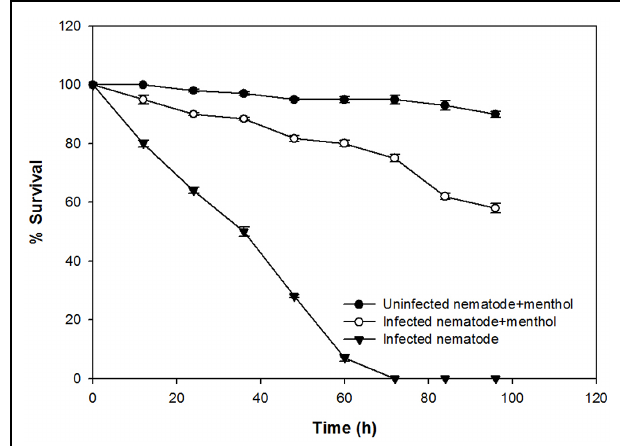
FIGURE 7 | Anti-infection potential of sub-MIC of menthol (800 µ g/mL) in increasing the survival of Caenorhabditis elegans preinfected with P. aeruginosa PAO1. Means values of triplicate independent experiments and SDs are